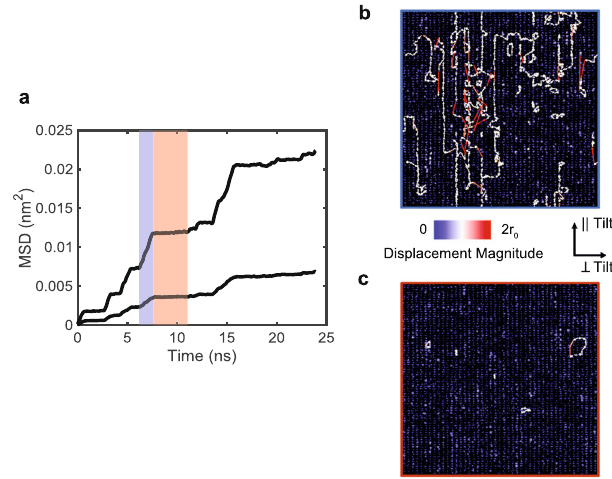
Fig. 2 Example of intermittent diffusion at intermediate